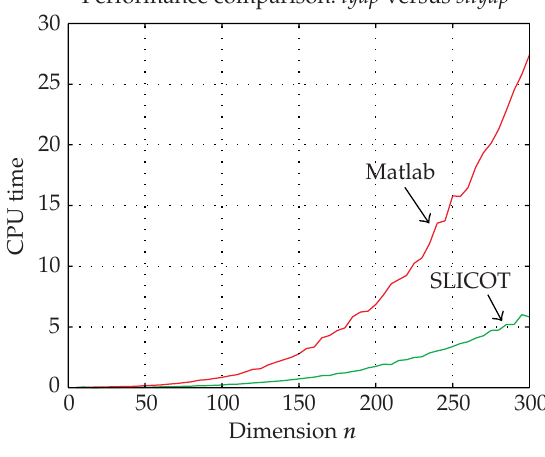
Figure 3.2 . CPU time comparison: sllyap versus Matlab 6.0 lyap.m